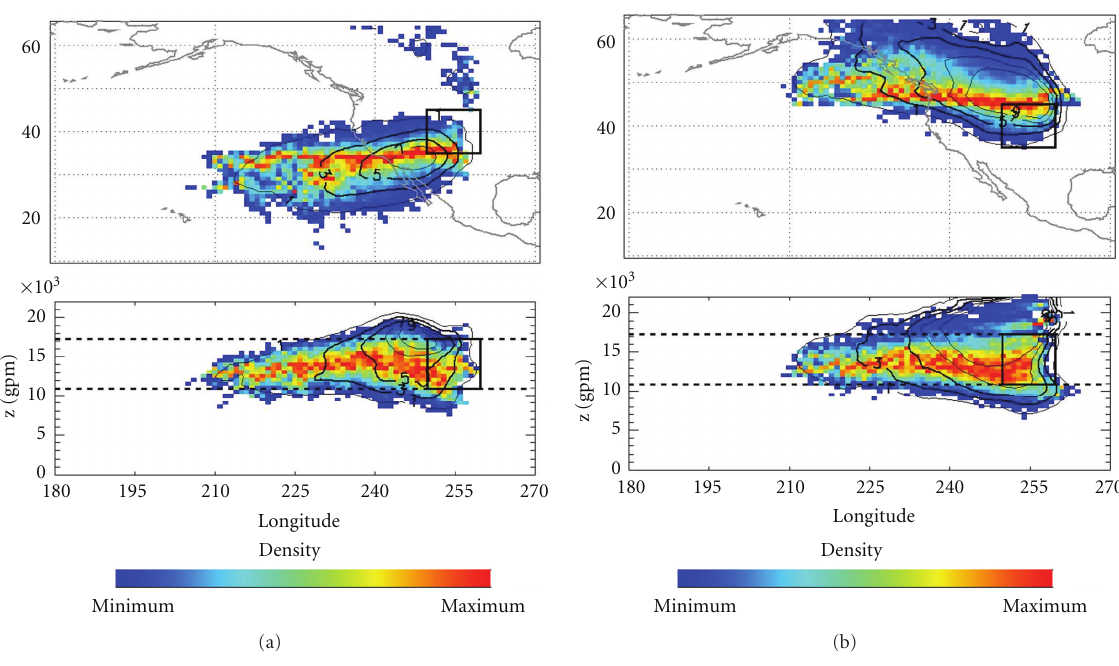
Figure 4: Similar to Figure 3(b) but (a) particles between the first and the second tropopauses whose origin 24 hours before t 0 was at a latitude to the South of 35 degrees. (b) Similar to (a) but for particles with their origin at latitudes to the North of 45